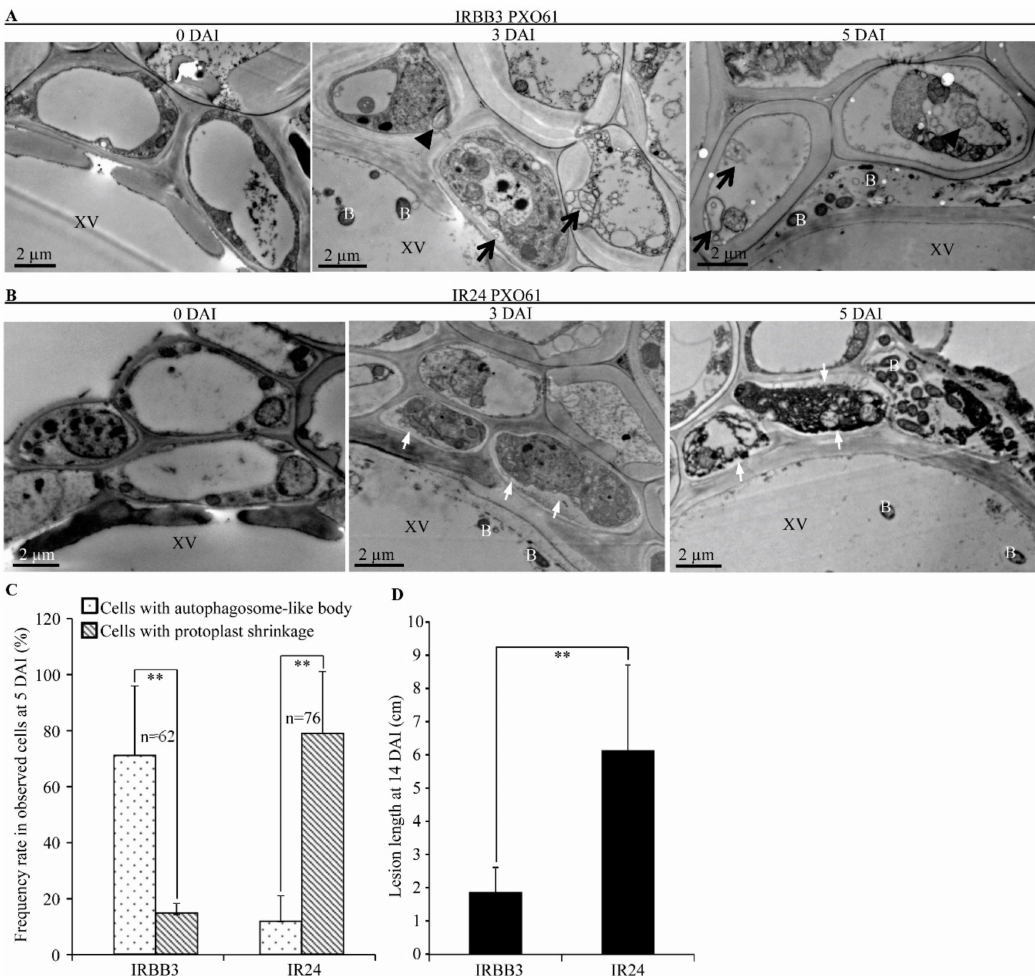
Figure 1. Autophagy-like ultrastructure features of xylem parenchyma cells in Xa3 / Xa26 mediated-resistance in comparison with protoplast shrinkage in susceptible reaction. XV, xylem vessel; B, Xoo bacteria; black arrow, autophagosome-like bodies with double membrane; black arrowhead, autophagosome-like body with single membrane; white arrow, protoplast shrinkage. ( A ) Autophagosome-like bodies in xylem parenchyma cells in IRBB3 plants infected with Xoo strain PXO61 at Day 3 and 5 after inoculation (DAI) in comparison with 0 DAI. ( B ) Protoplast shrinkage of xylem parenchyma cells in IR24 plants inoculated with Xoo strain PXO61 at 3 and 5 DAI, in comparison with 0 DAI. ( C ) Percentage of cells with autophagosome-like bodies and protoplast shrinkage in xylem parenchyma cells at 5 DAI. Data are presented as mean (62–76 xylem parenchyma cells of three xylem vessels from three di ff erent plants) + standard deviation (SD). Double asterisks (**) stand for a significant di ff erence between frequency rate of cells with autophagosome-like body and frequency rate of cells with protoplast shrinkage at p < 0.01; n, the number of total observed cells. ( D ) Leaf lesion length of IRBB3 and IR24 challenged with Xoo at 14 DAI. Bars represent mean (10–20 leaves from four plants) + SD. Double asterisks (**) stand for the significant di ff erence between resistant and susceptible plant at p <